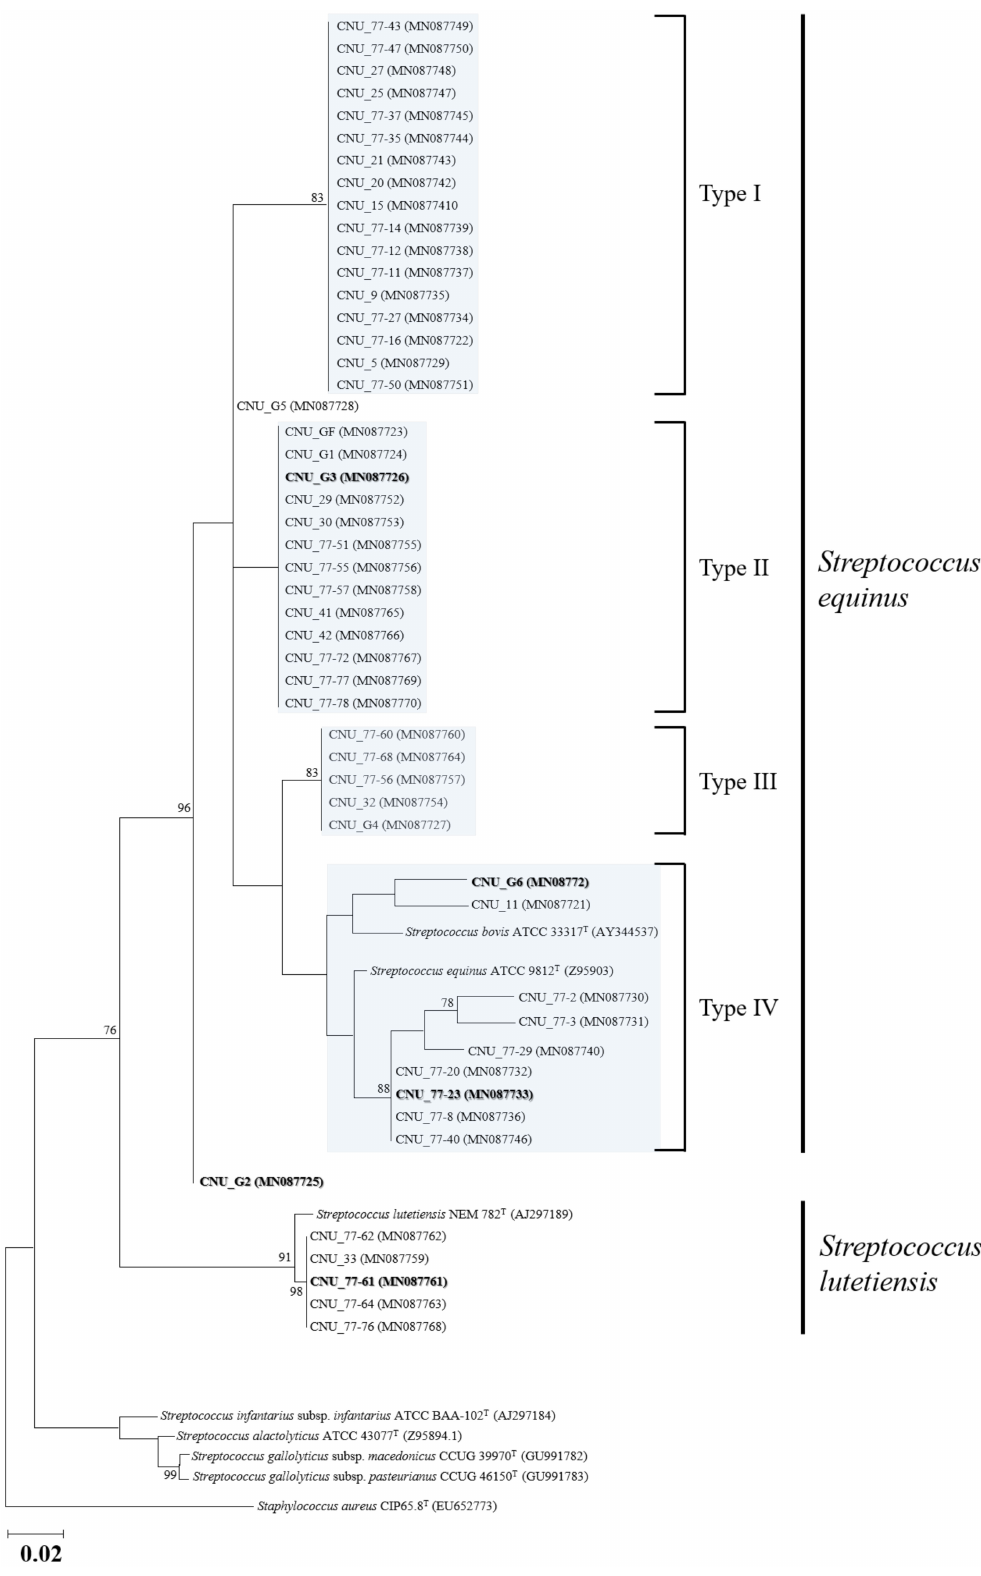
Figure 1. Maximum-likelihood phylogenetic tree based on sodA nucleotide sequences showing the relationships of all Streptococcus isolates reported in this study with seven representative sodA sequences in SBSEC and the outgroup Staphylococcus aureus CIP65.8 T . The blue square boxes denote the presence of four major types (type I, II, III, and IV) of S. equinus isolates obtained in this study. The scale bar represents 0.02 nucleotide substitutions per site. The five representative genomes are emphasized in